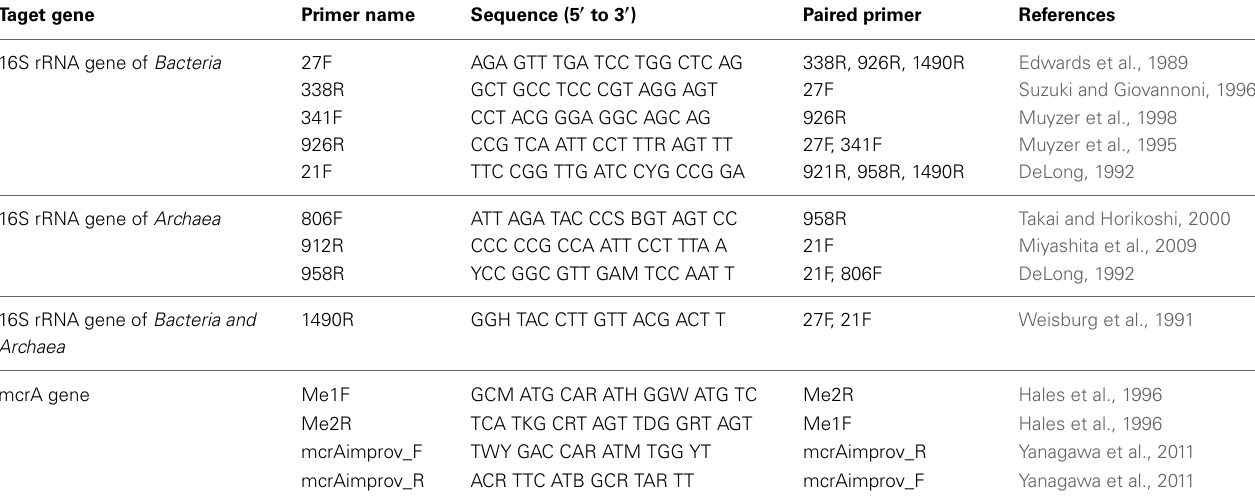
Table 1 | List of the primer sets for